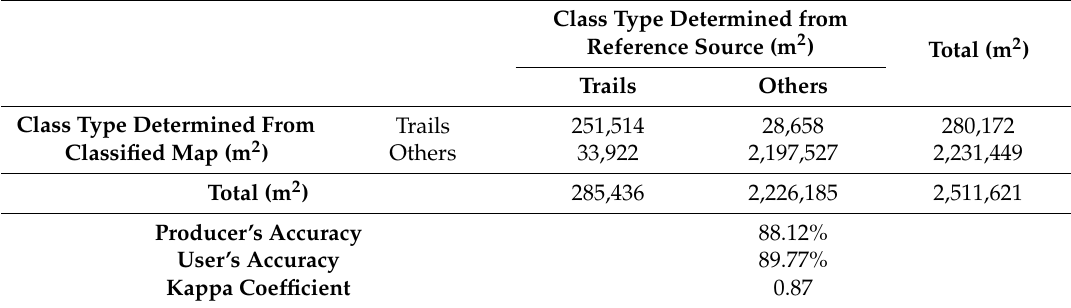
Table 3. Accuracy assessment of trail results from the research area determined from similarity matrix. Reference sources are 20 visually interpreted reference areas, each a 20 m radius circle.